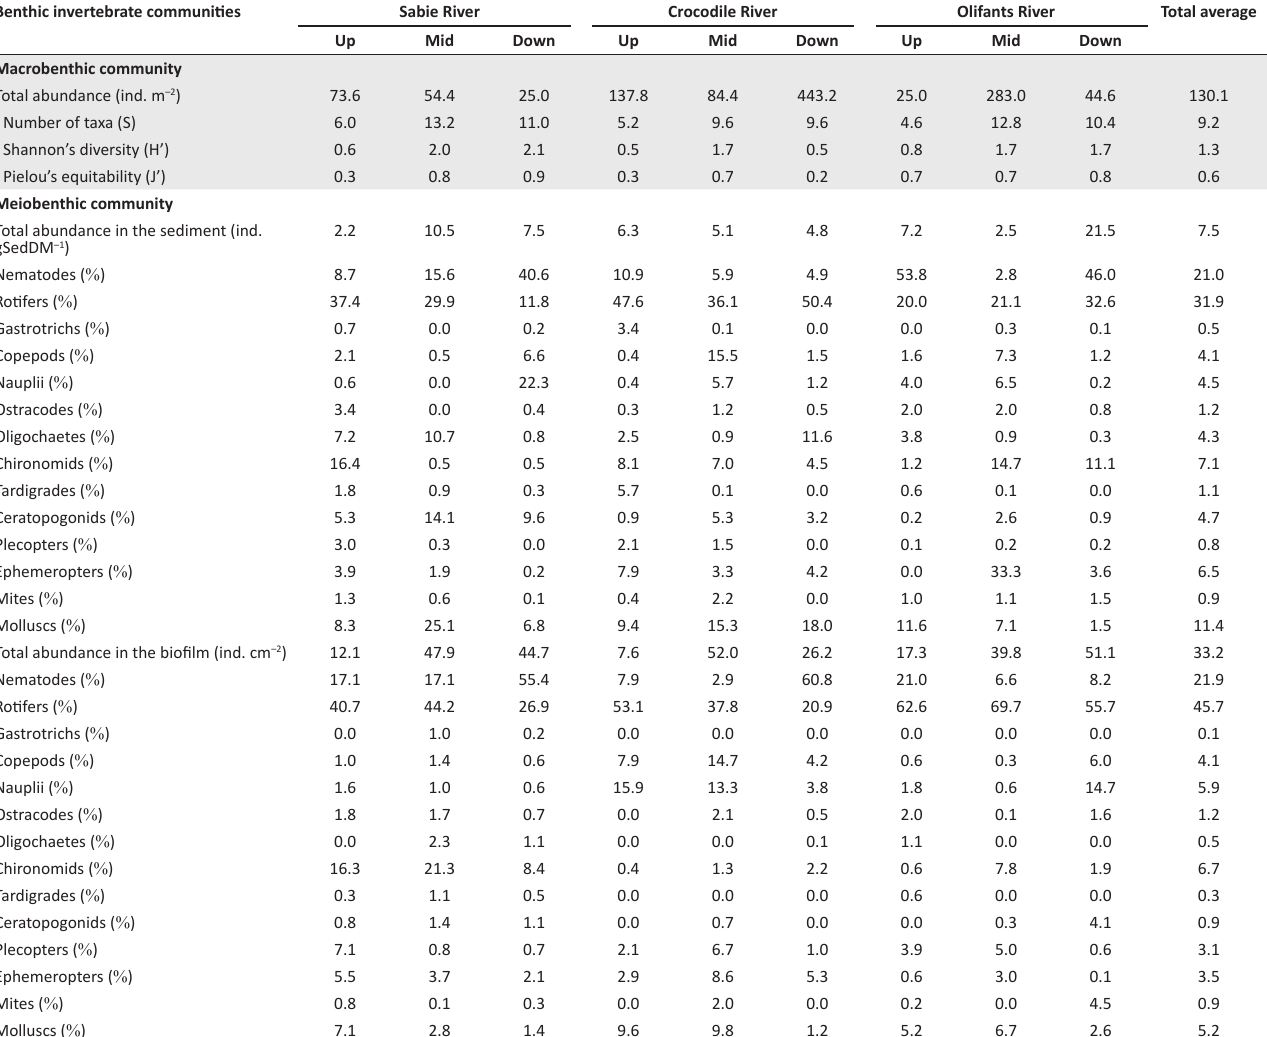
TABLE 2: Abundance, diversity and taxonomic composition of benthic invertebrate communities in three rivers flowing through the Kruger National Park (detailed taxonomic composition for macrobenthic invertebrates is presented in Table 1-A1). Benthic invertebrate